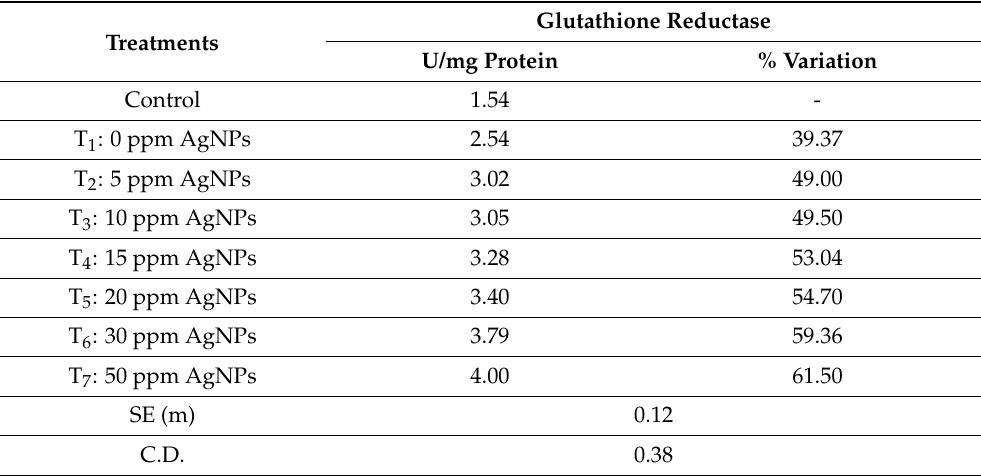
Table 7. Estimation of Glutathione reductase activity in spot blotch infected wheat plant leaves in response to nanoparticle